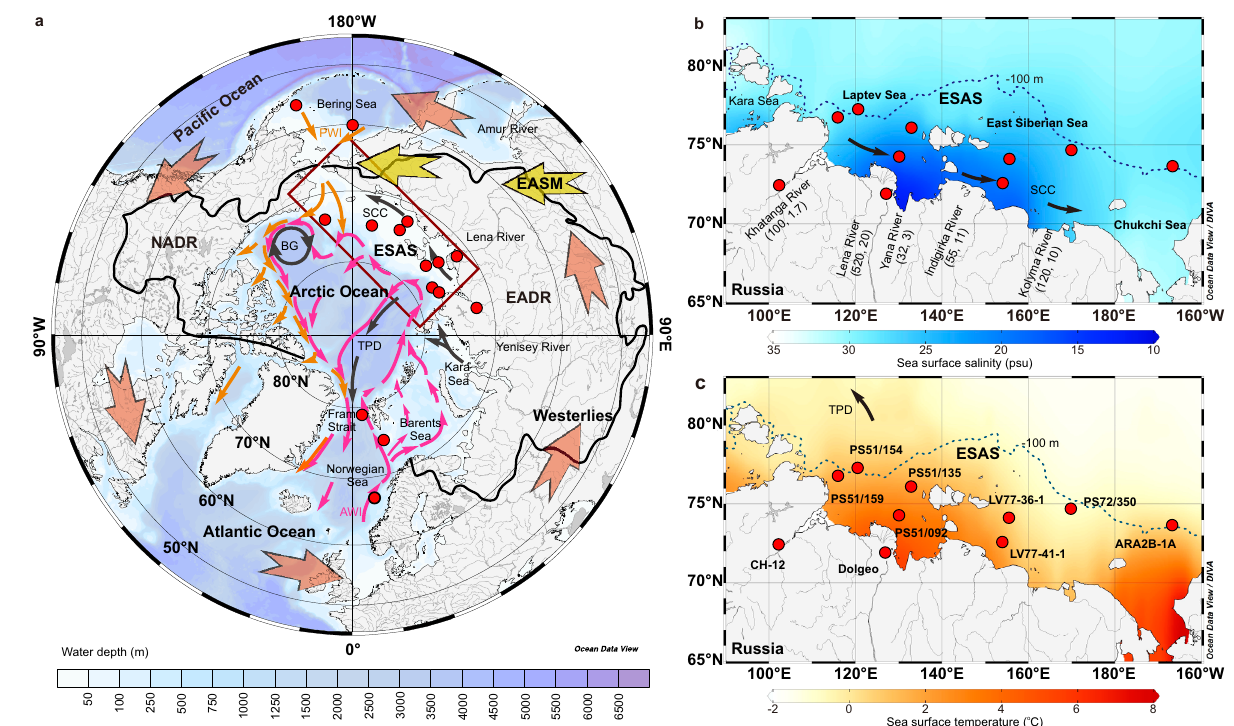
Fig. 1 | Map of the modern pan-Arctic region with insets of the East Siberian ArcticShelf(ESAS)area.a Pan-Arcticriversystem,ArcticOceancirculation(arrow lines) 17,24 ,NorthernHemispherewesterlies(orangearrows),andEastAsiansummer monsoon (EASM, yellow arrows). Sea surface ( b ) salinity and c temperature (color scales) during July – September in the ESAS region, with mean annual Russian pan- Arctic major river runoffand sediment load(km 3 /yr and Mt/yr,respectively) 23 . The